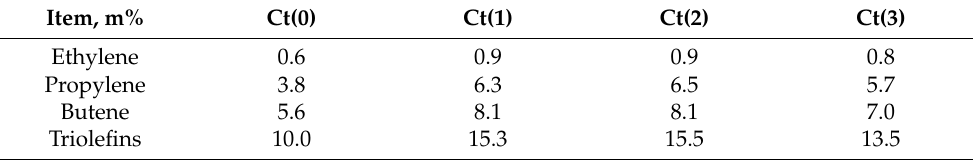
Table 10. Yield of light